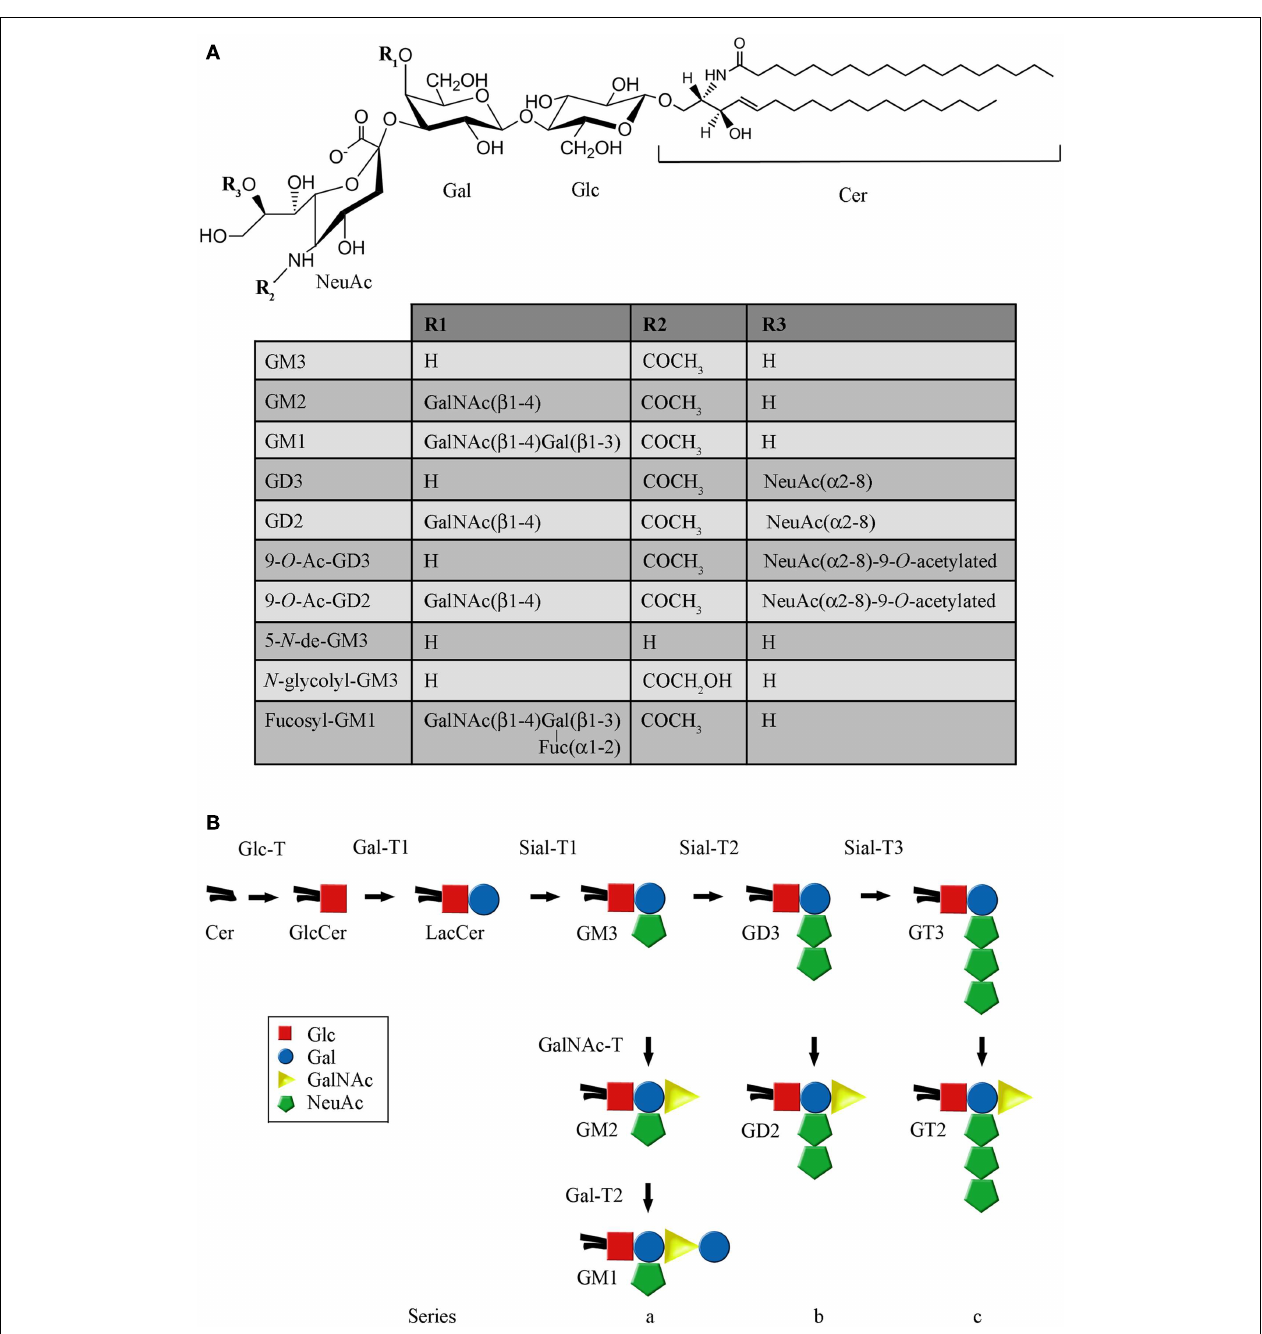
FIGURE 1 | Structure and representative reactions of ganglioside biosynthesis . (A) Chemical structure of the main gangliosides mentioned in this work. (B) Schematic representation of the main pathway of ganglioside biosynthesis.The full names of the abbreviations are indicated in the text.